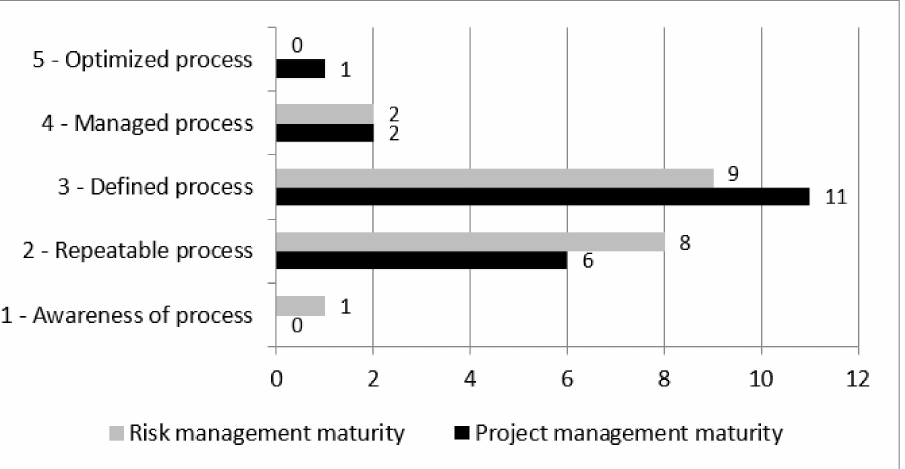
Figure 2. The respondents’ assessment of the project management and risk management maturity levels in their